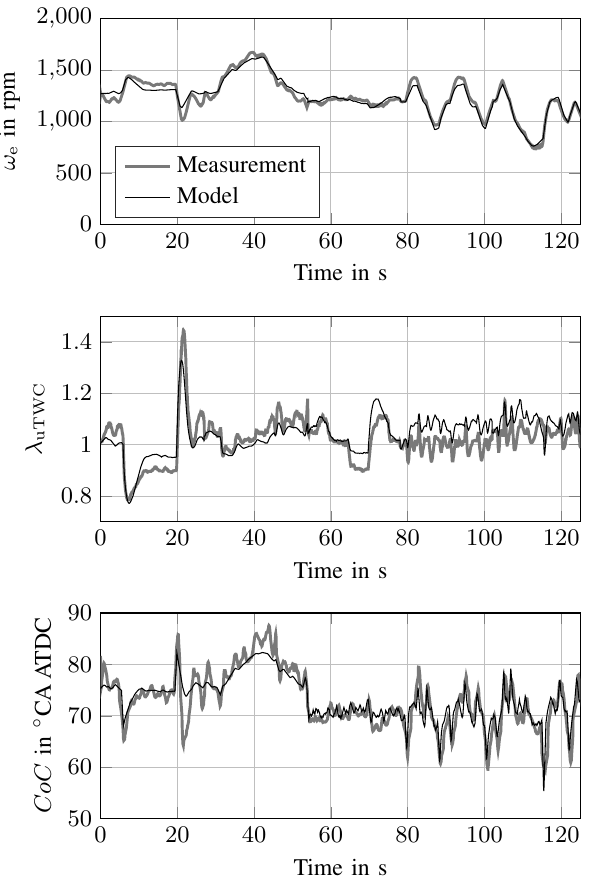
Figure 2. Validation of the mean-value engine model.